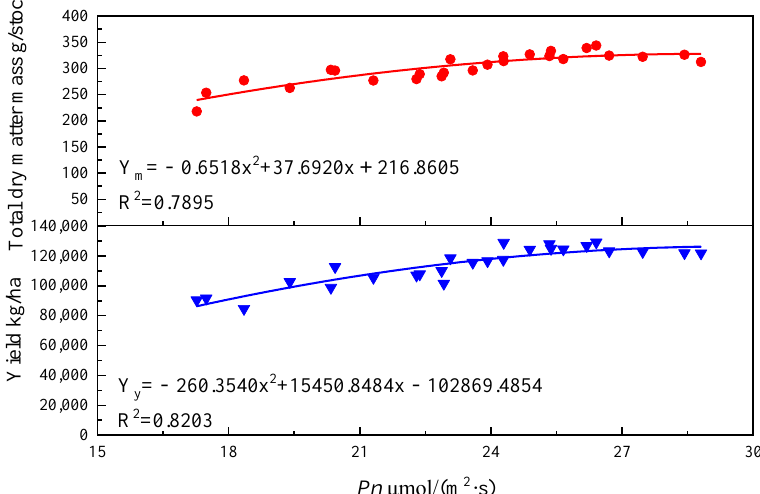
Figure 4. Correlation between Pn of tomato leaves and total dry matter mass and yield. Note: Y m represents the total dry matter mass, Y y represents the yield, x represents the photosynthetic rate ( Pn